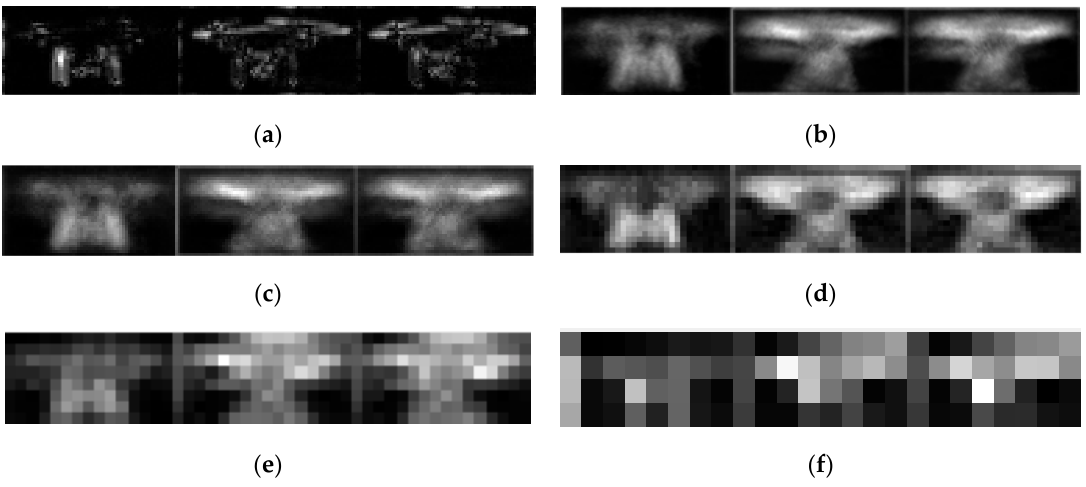
Figure 5. Reconstructing feature image after downsampling and NMFsc: ( a ) Log-Gabor feature; ( b ) reconstructing image of Log-Gabor feature after NMFsc; ( c ) reconstructing image of Log-Gabor feature after downsampling once and NMFsc; ( d ) reconstructing image of Log-Gabor feature after downsampling twice and NMFsc; ( e ) reconstructing image of Log-Gabor feature after downsampling three times and NMFsc; ( f ) reconstructing image of Log-Gabor feature after downsampling four times and NMFsc.